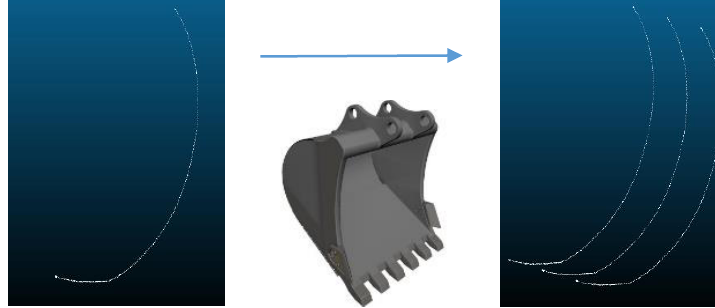
Figure 7. Conversion of 2D bucket path to 3D spatial trajectory.